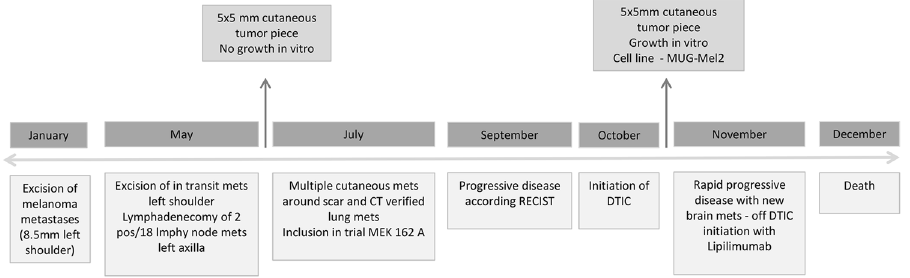
Figure 1. Clinical course and date of MUG-Mel2 cell line